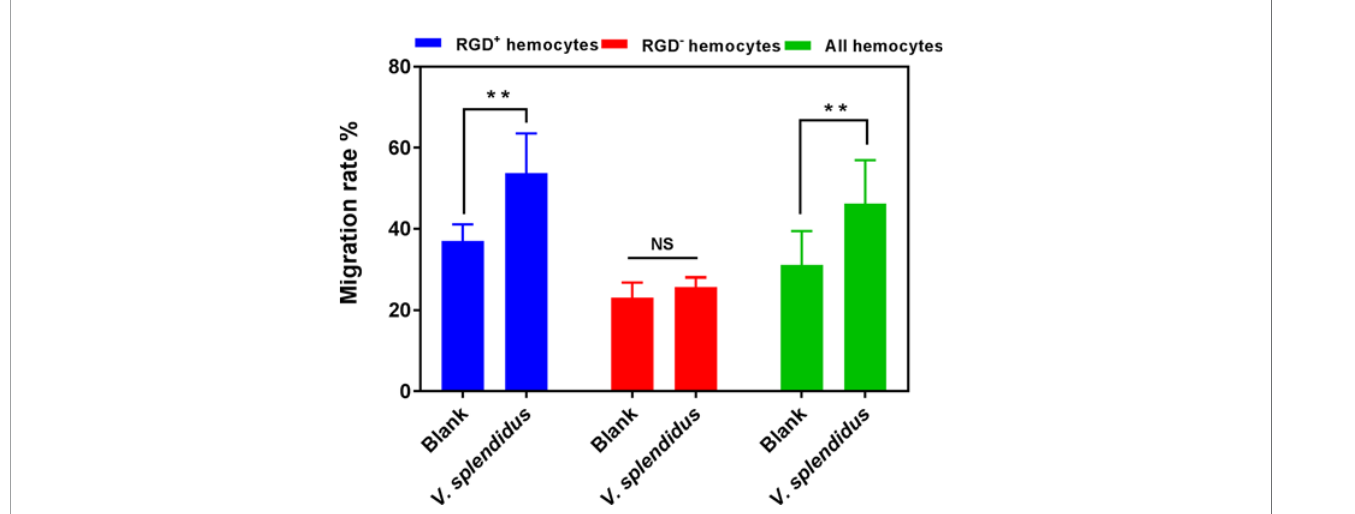
FIGURE 4 | The migration activity of RGD + hemocytes before and after V. splendidus stimulation. The double asterisk (**) stands for statistical signi fi cance at p < 0.01, and “ NS ” represents no statistical signi fi